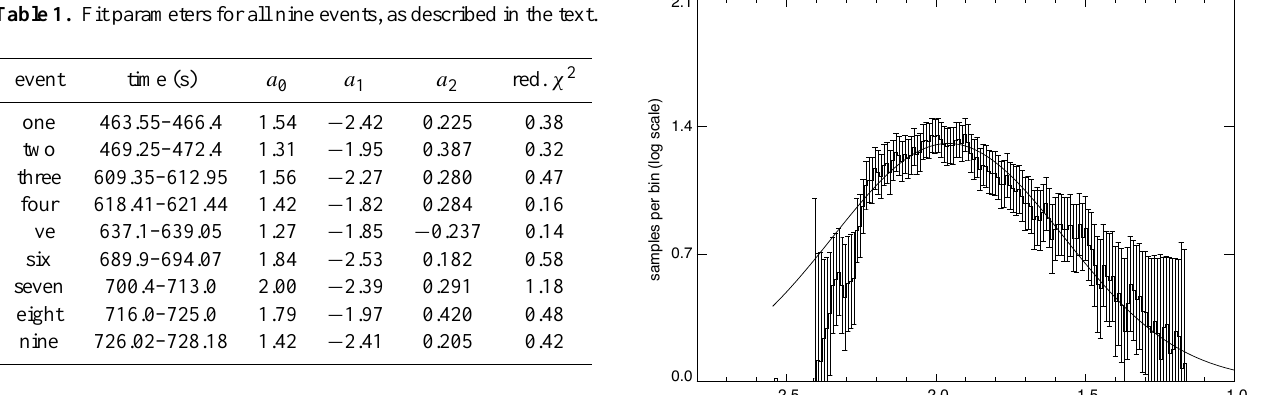
Fig. 5. Histograms of the effective number of samples, N eff , versus the logarithm of the electric field ampli- tude, applying a 2.6 ms running average, for all nine events labeled in Figure 1b. Lighter traces show Gaussian models (in log E ) ) fitted to the observed range of fields. Error bars reflect estimates of statistical uncertainty as described in the text.